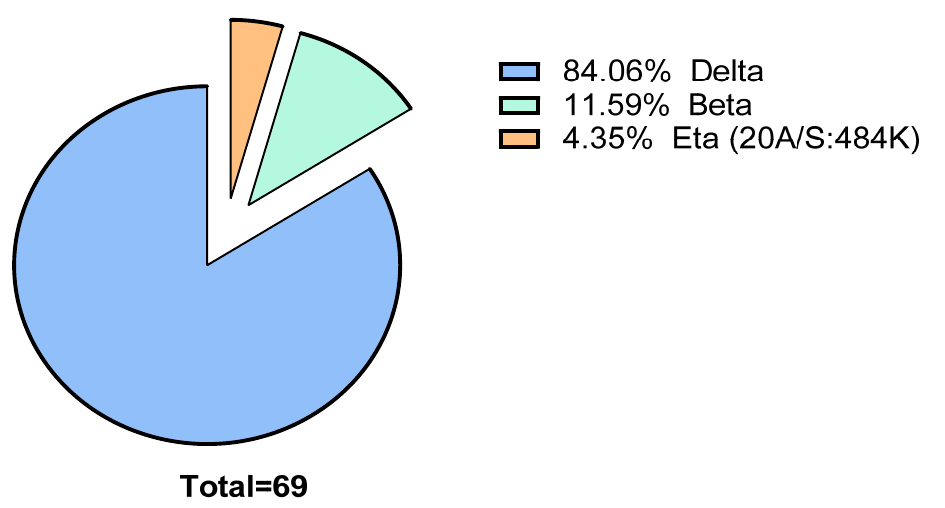
Figure 5. A pie chart depicting the circulating variants during the study. It also represents the variants among the RT-PCR and RDT positive patients who came to the diagnostics facility in the particular study time frame.